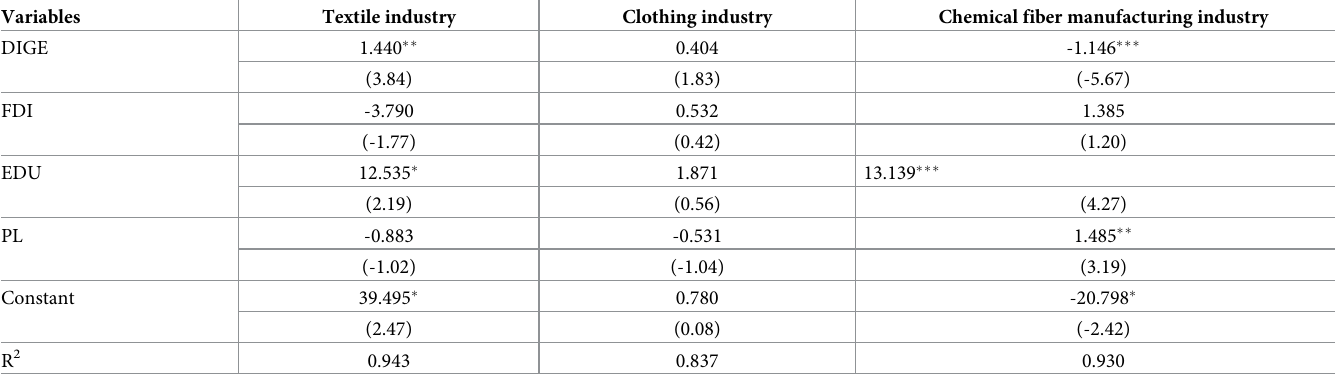
Table 8. Results of heterogeneity analysis in textile and apparel industry. Variables